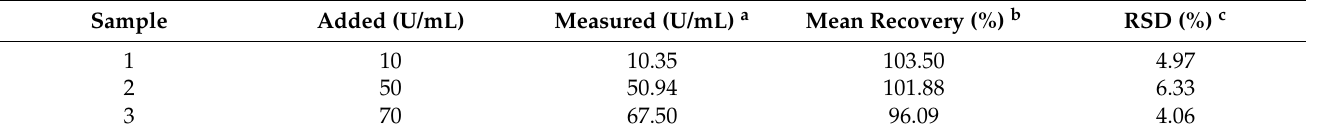
Figure 3. Detection of MTase in 10% human serum. ( A ) Fluorescence intensities with various concentrations of M.SssI in 10% human serum; ( B ) relationship between the fluorescence intensity and MTase concentration with the scope of 0.5 to 110 U/mL. Table 2. Recovery studies of M.SssI in 10% human serum.